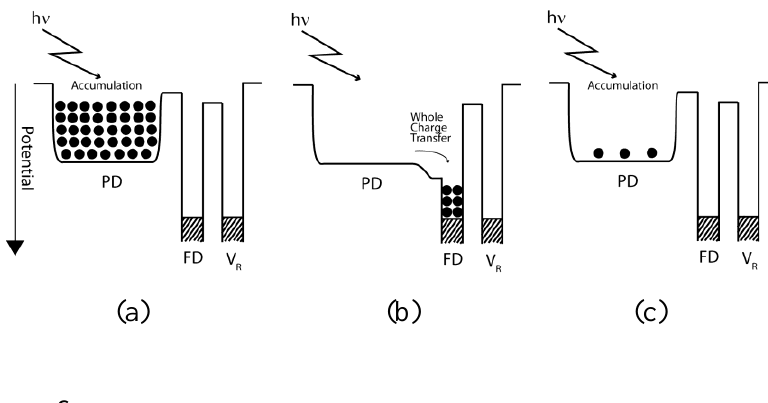
Figure 2. The principle of Whole Charge Transfer, (a) charge accumulation (b) charge transfer (c) new charge accumulation.